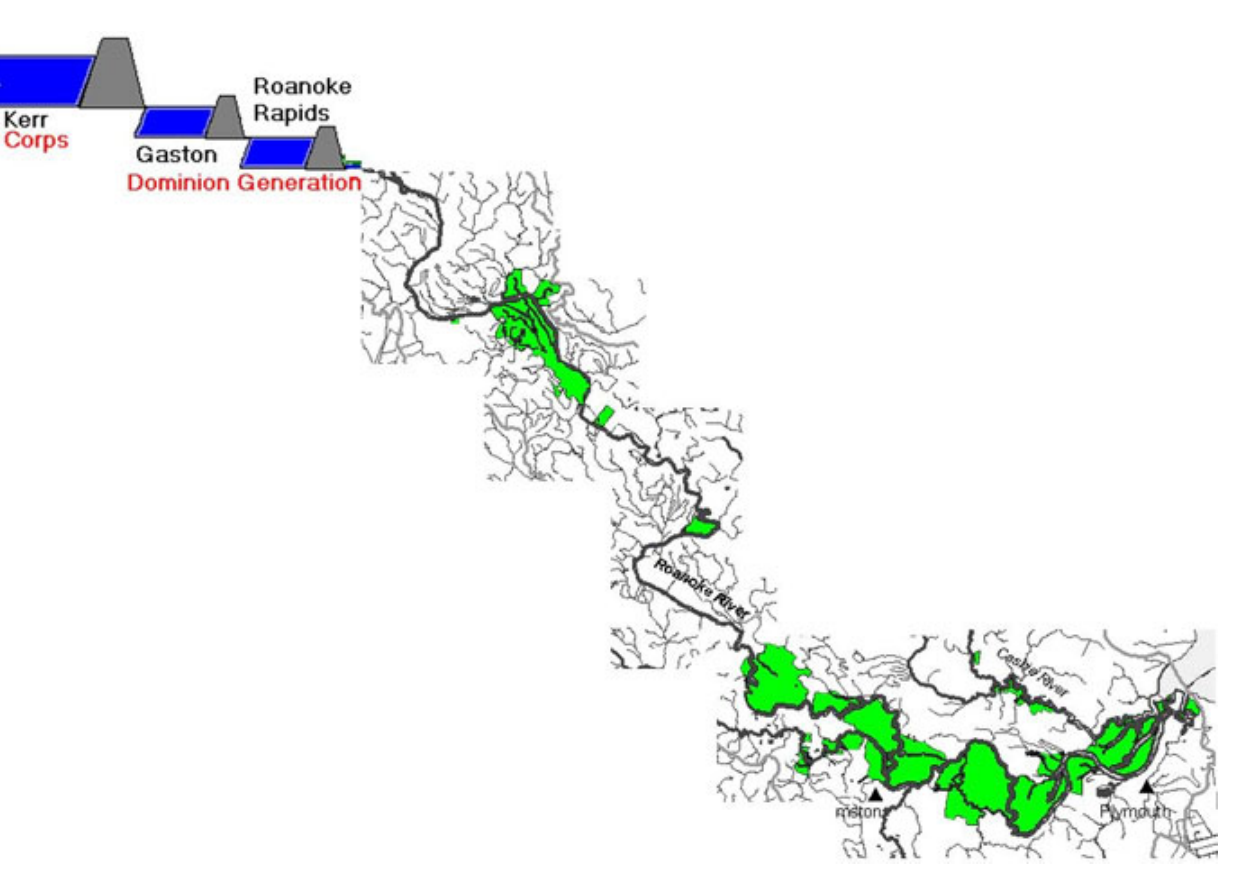
Fig. 2 . Schematic indicating three dams and downstream conservation